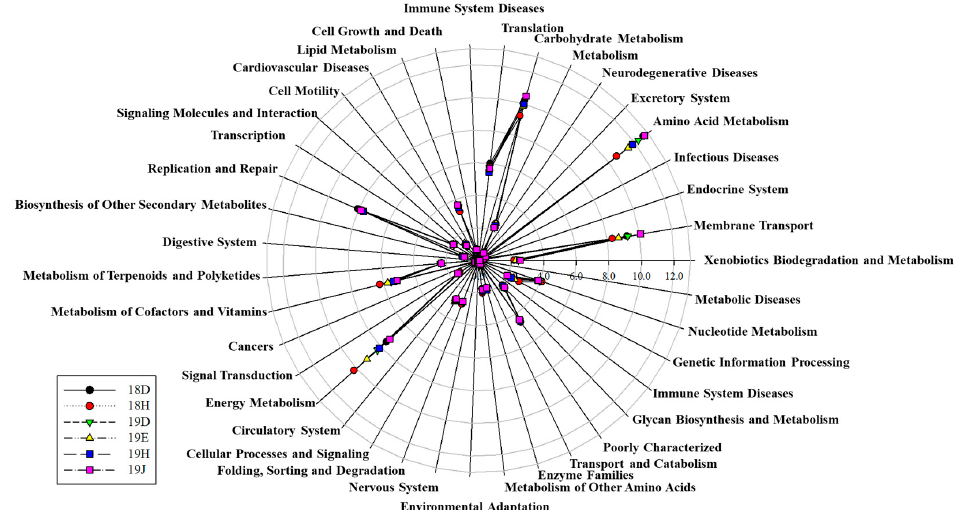
Figure 6. Microbial OTUs associated with C. polykrikoides are related to gene functional pathways. Gene functions were predicted from 16S rRNA gene-based microbial compositions using the PICRUSt algorithm to make inferences from KEGG pathways .